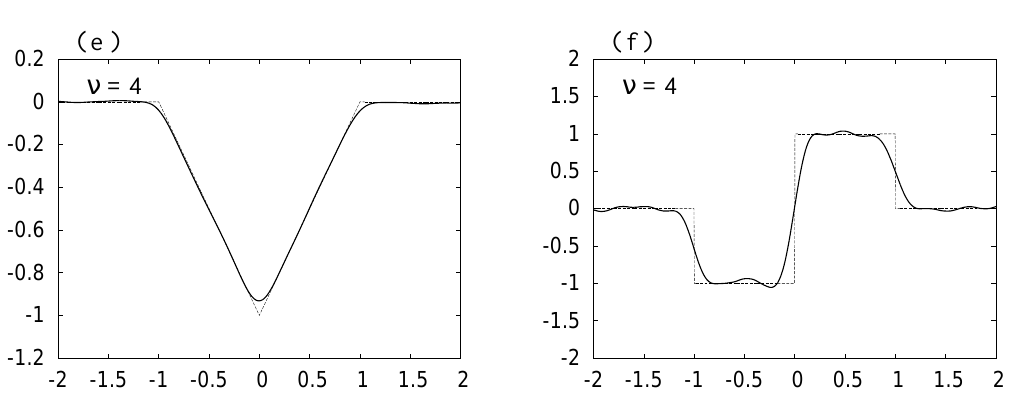
f ) ′ ( x ) and ( M ν 1 and u ( w ) = u 3